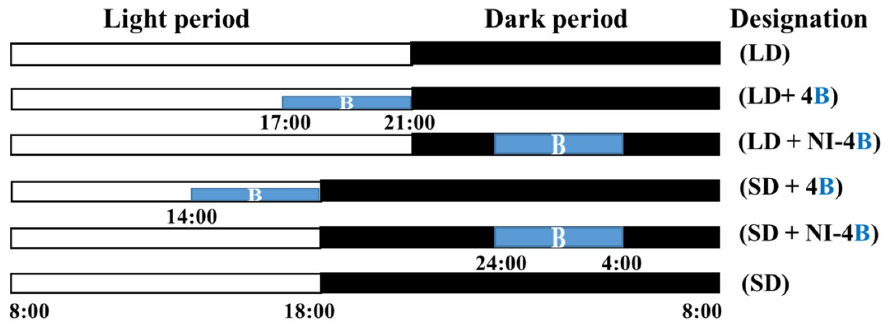
Figure 2. Supplementary and night-interrupting B light schemes employed in this study: The control plants were exposed to a 10-h short-day (SD, positive control) or 13-h long-day (LD, negative control) treatments without any B light. The B light was used for 4 h either (1) to supplement the W LEDs at the end of the SD (SD + 4B) and LD (LD + 4B) or (2) to provide night interruption (NI) in the SD (SD + NI-4B) and LD (LD + NI-4B). The light period began at 8:00 a.m, and the dark period ended at 8:00 am.